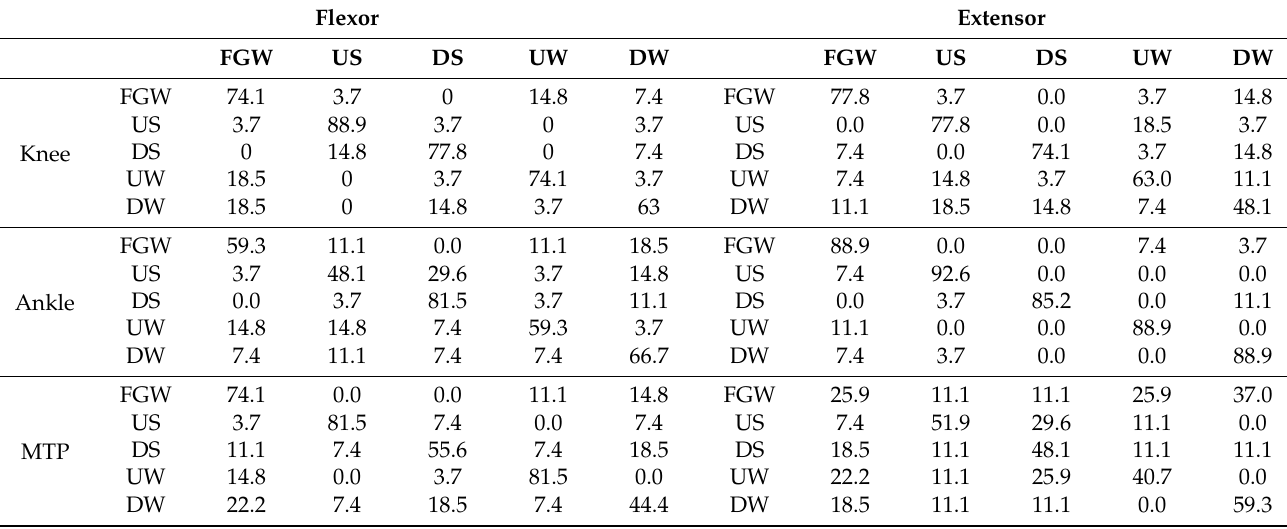
Table 5. The confusion matrix for classifying the walking environment using only sEMG signals from the flexor and extensor muscle groups of the ankle, knee, and metatarsophalangeal (MTP)